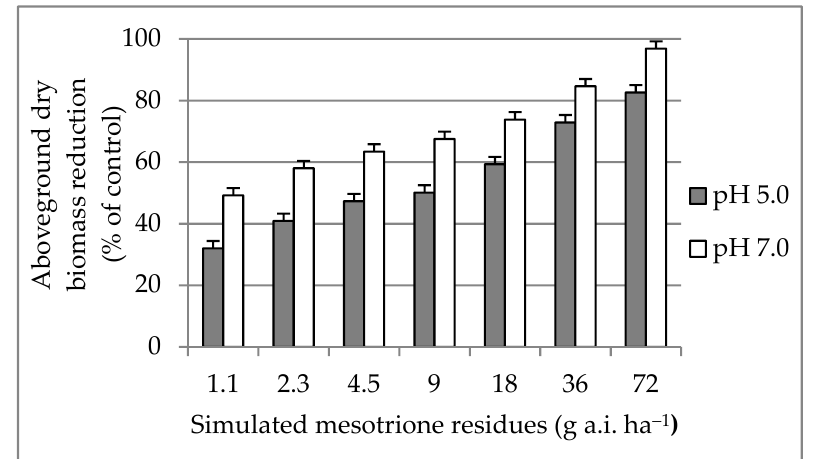
Figure 3. Reduction in aboveground dry biomass (% of control) of pea plants treated with simulated mesotrione residues applied to soil at pH 7.0 and pH 5.0. Vertical lines indicate a statistical difference according to Fisher’s LSD test at p ≤